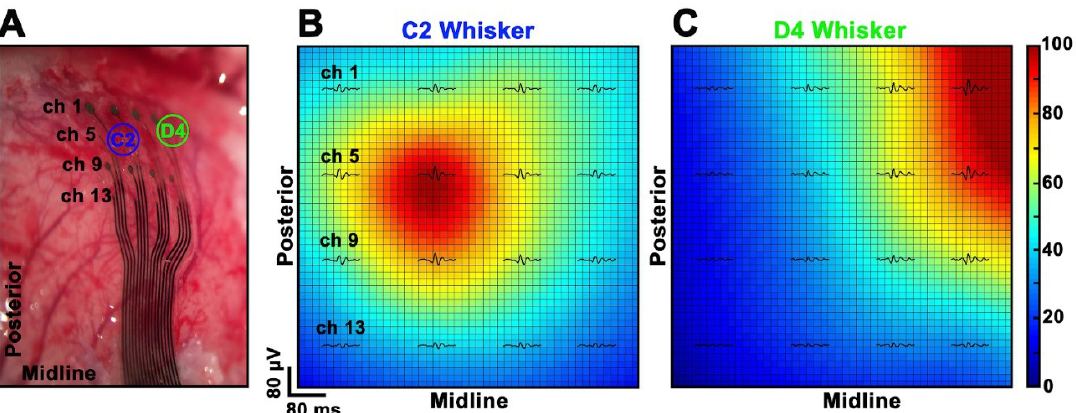
Figure 10. ( A ) Picture of the array over the barrel cortex where the position of the barrels of interest are overlaid. ( B , C ) Interpolated maps of the averaged SEPs obtained after stimulating the C2 and the D4 whiskers showing the expected somatotopic shift. The colormap reflects the SEPs sizes normalized in the range [0, 100] independently for each experimental condition.